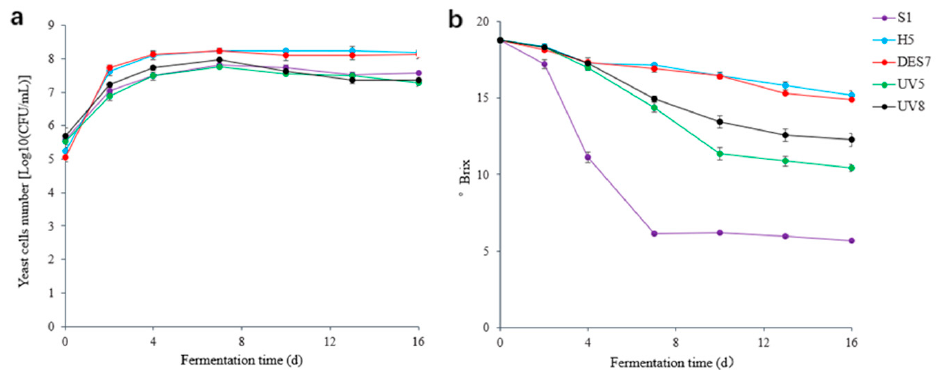
Figure 4. ( a ) The changes in the colony numbers during fermentation; ( b ) changes in the °Brix values of the different fermentation groups during fermentation.